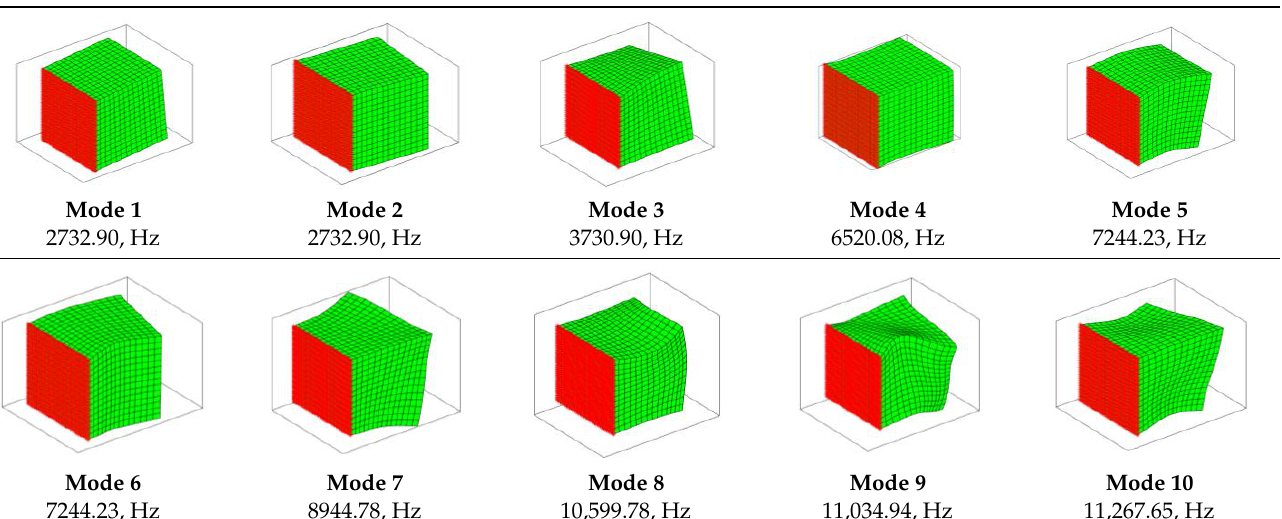
Table 4. Natural frequencies and modal shapes of the first 10 modes computed for the reference model.